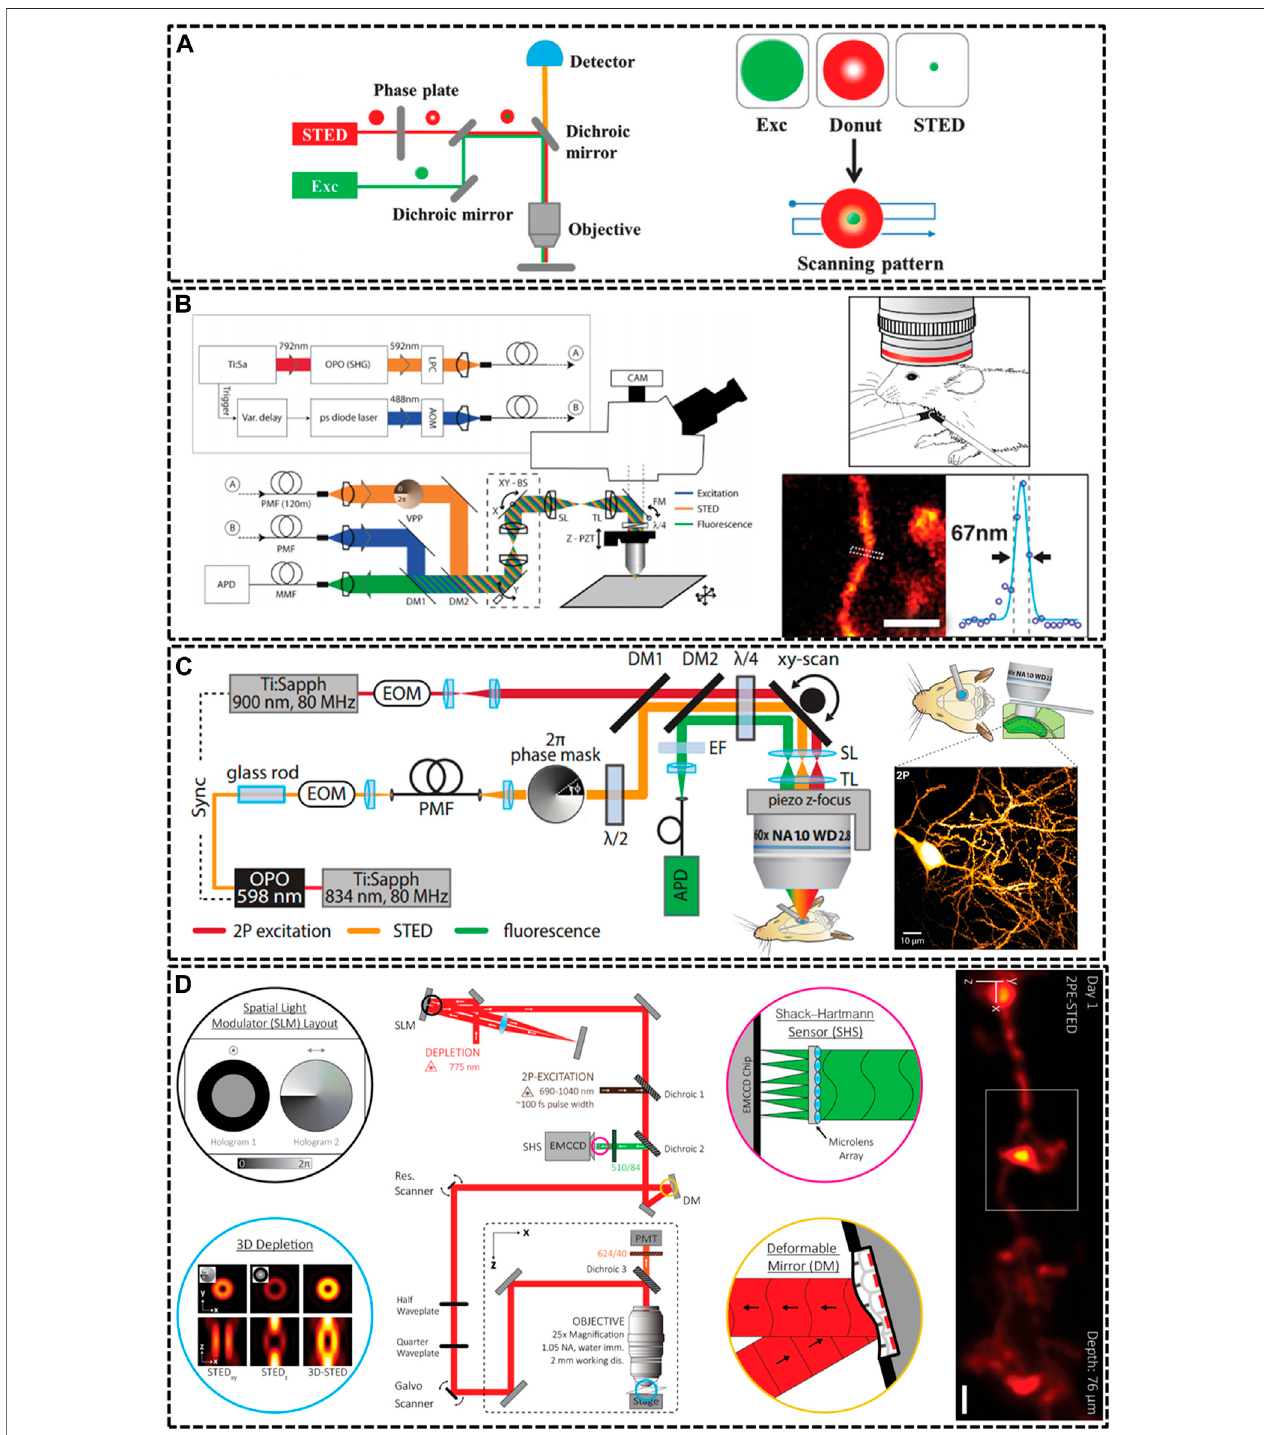
FIGURE 1 | Overviewofmodi fi edSTEDmicroscopyfor invivo imaging. (A) TheprincipleofSTEDtechnique.Thecombinationofexcitationlaseranddonut-shapedSTEDlaser could decreasethesizeofPSFeffectively (Yangetal.,2016). ReprintedfromYangetal.(2016) withpermissionfrom RoyalSociety ofChemistry. (B) Schematicdrawingoftheupright scanning STED for in vivo imaging (Berning et al., 2012). Reprinted from Berning et al. (2012) with permission from American Association for the Advancement of Science. The STED imageofdendriticandaxonalstructureswasobtainedfromalivingmousebrainundertheobjectivelens(1.3NA,glycerolimmersion).Scalebar,1 μ m. (C) Diagramoftwophoton (2P)STEDmicroscope(Pfeifferetal.,2018).The2PimagedepicteddendritesofpyramidalneuroninhippocampalCA1region.Scalebar,10 μ m.ReprintedfromPfeifferetal.(2018)with permission from eLife Sciences. (D) Schematic of aberration-corrected 3D-2P-STED instrument (Velasco et al., 2021). The microscopy equipped with a double-pass spatial light modulator(SLM)toimpartboththevortexandtop-hatphasemasksonthedepletionbeam.Super-resolutionimageshoweda3Ddendriteat76 µmbelowthecorticalsurface.Scale bar: 1 µm. Reprinted from Velasco et al. (2021) with permission from Optical Society of America.